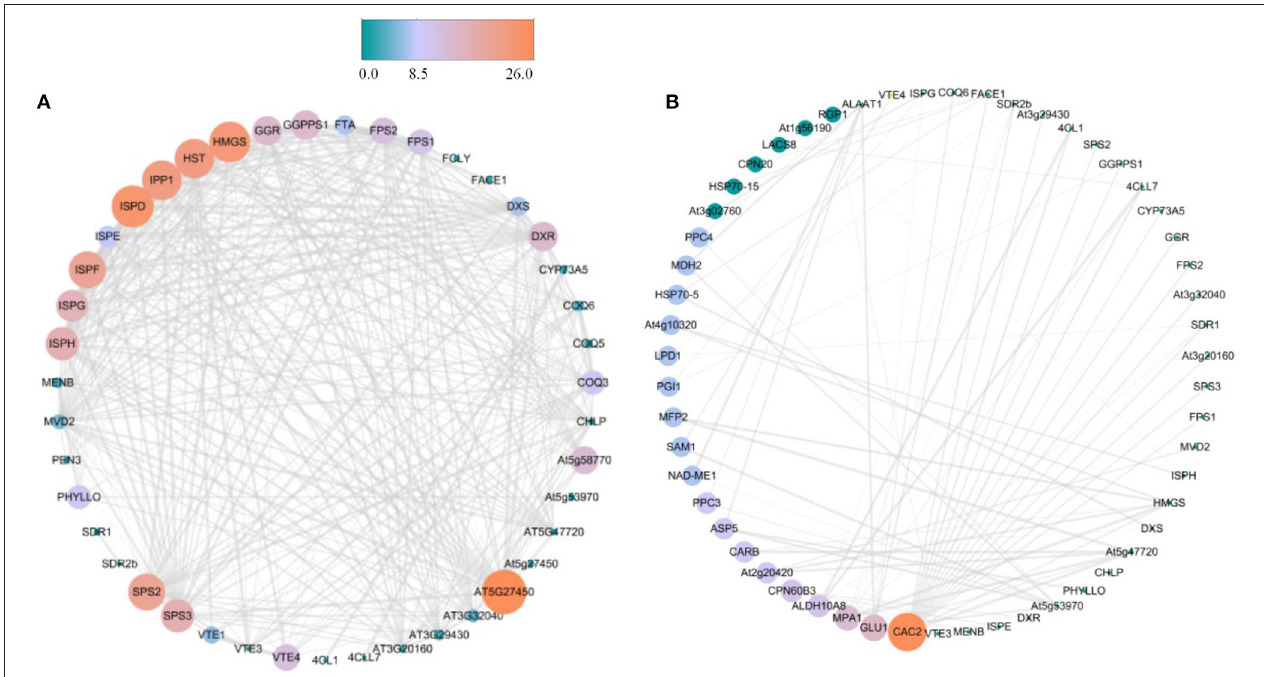
FIGURE 3 | PPI analysis of proteins associated with terpenoid synthesis in R. glutinosa. (A) PPI analysis between proteins of terpenoid synthesis in R. glutinosa , (B) PPI analysis between proteins of terpenoid synthesis and others in R. glutinosa . The size and color of the circle represents the indegree of PPI, atrovirens circle is low values, but jacinth circle is high